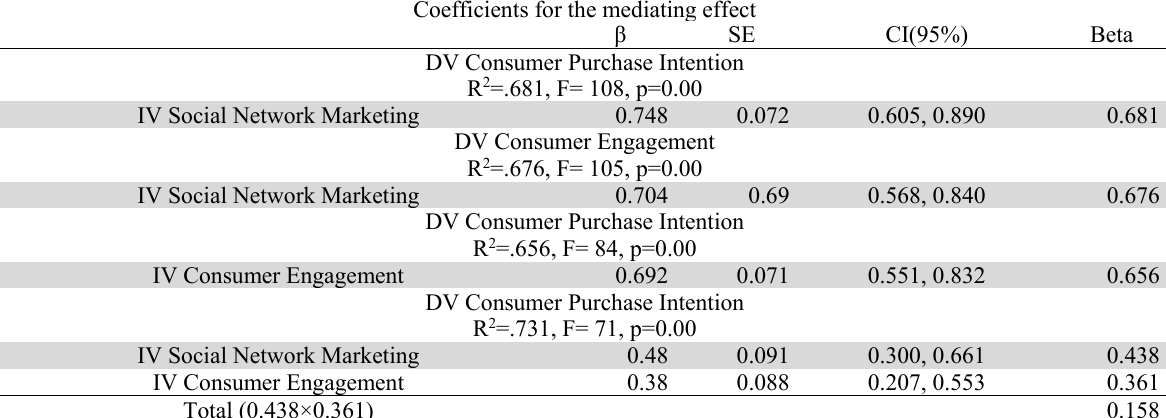
Testing Mediating effect of Consumer Engagement on Consumer Purchasing Intention Coefficients for the mediating